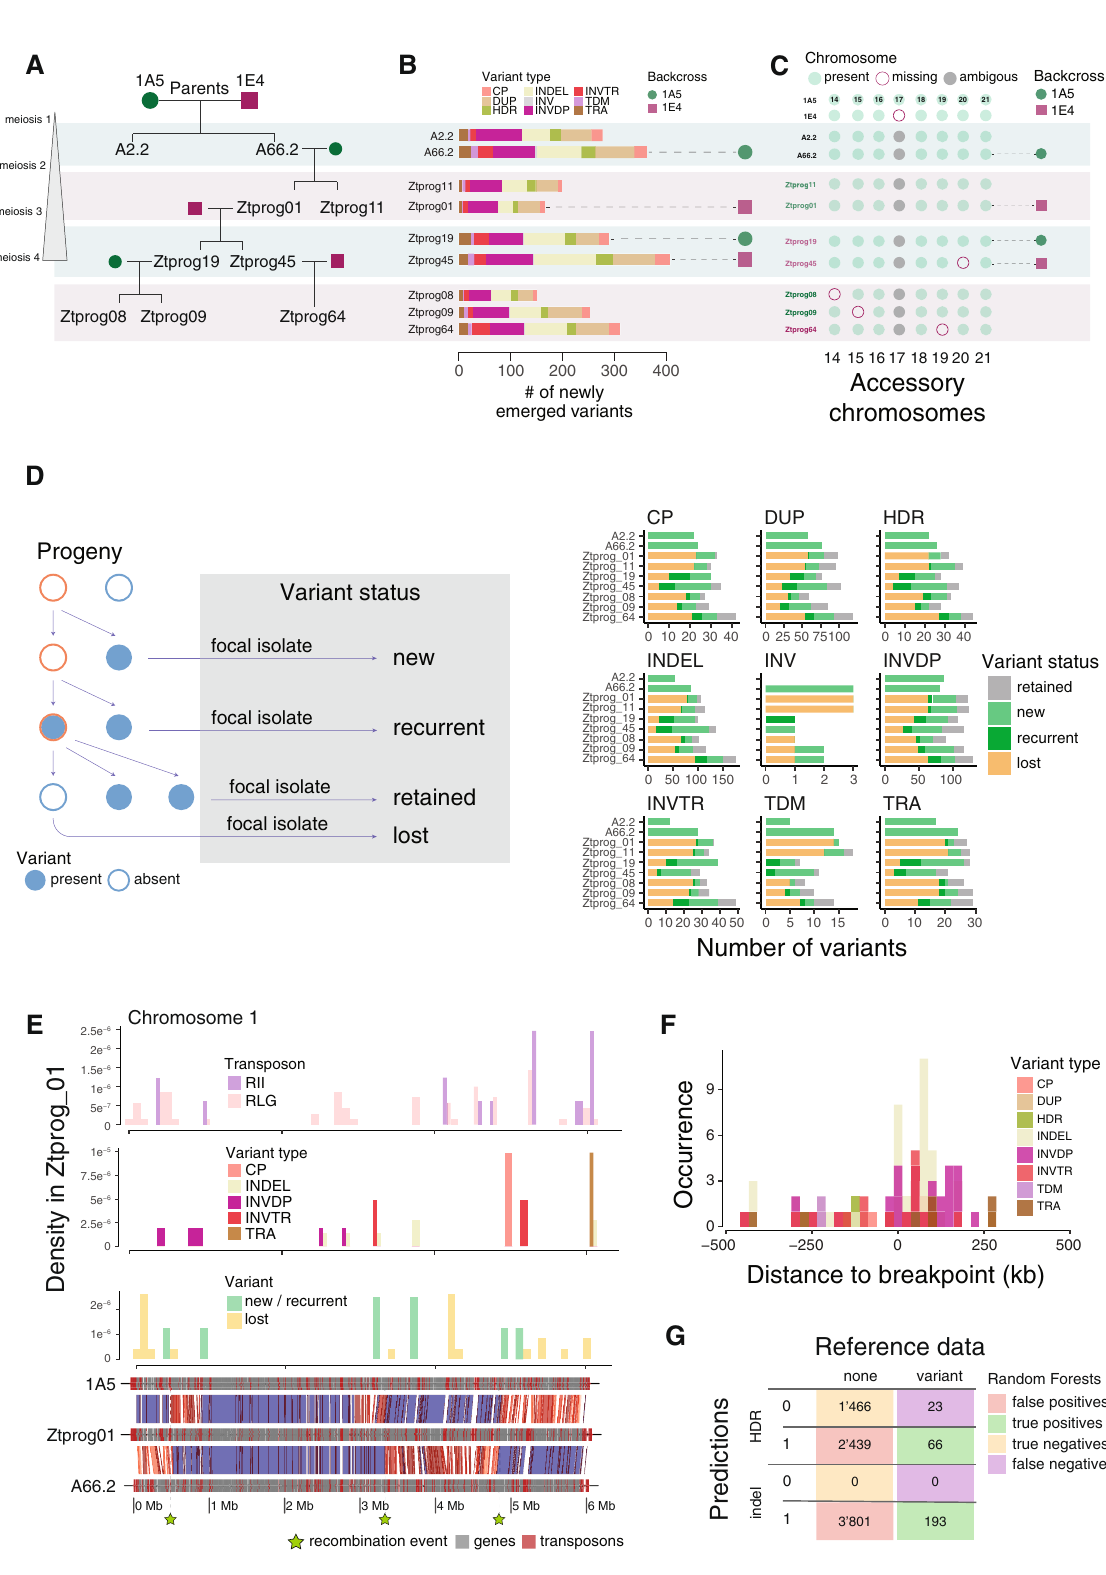
to be in regions of high synteny (Supplementary Fig. 13). On the contrary, true positives tend to be in regions of low synteny compared to false positives in particular for inverted duplications (Wilcoxon rank-sum test, p -value < 0.05). This suggests that model over-predictions are caused by variation in synteny between the two parental genomes (Supplementary Fig. 13). False positives are found in regions of higher recombination rate